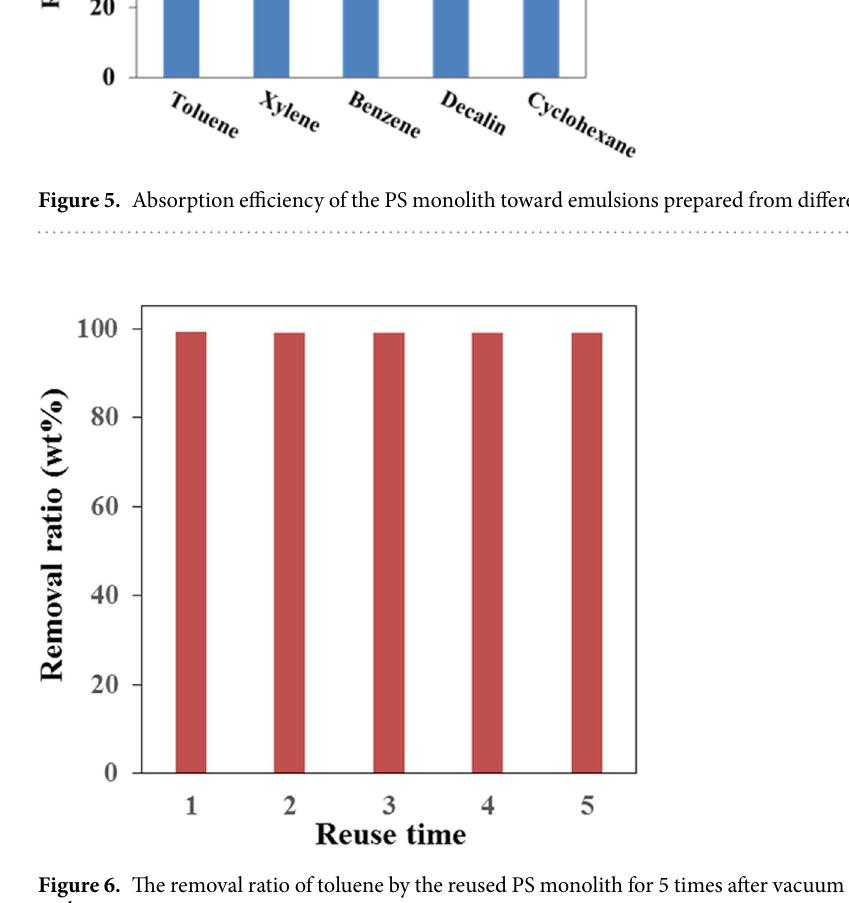
Figure 6. The removal ratio of toluene by the reused PS monolith for 5 times after vacuum drying between each